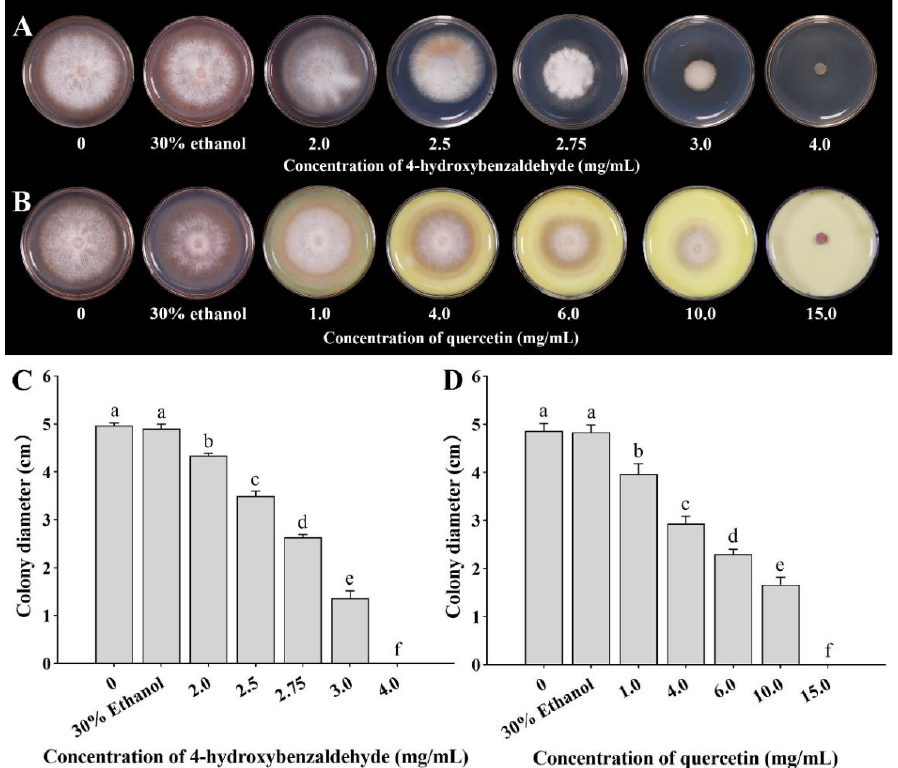
Figure 7. Effects of different concentrations of 4-hydroxybenzaldehyde ( A , C ) and quercetin ( B , D ) on colonial morphology ( A , B ) and colony diameter ( C , D ). The bars on the columns represent standard deviations, and different letters on the bars represent significant differences ( p <